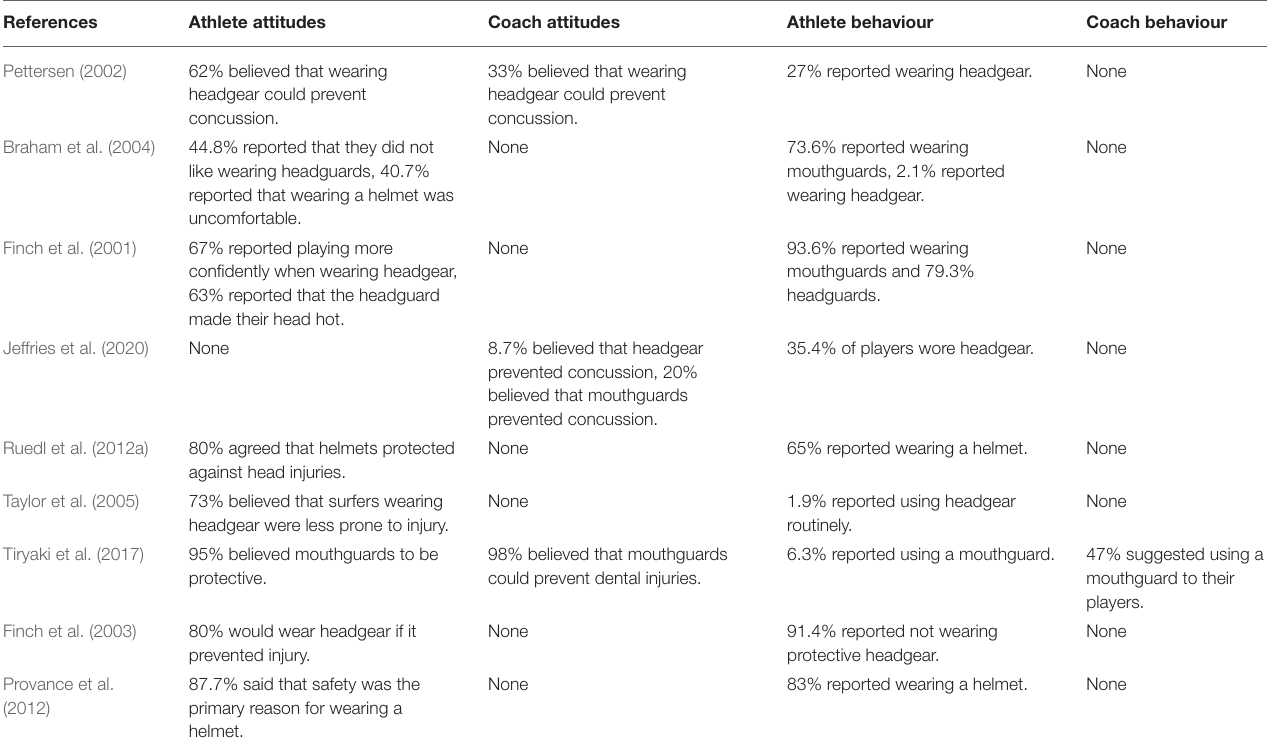
TABLE 4 | Summary of studies reporting on athlete/coach attitudes and behaviour in